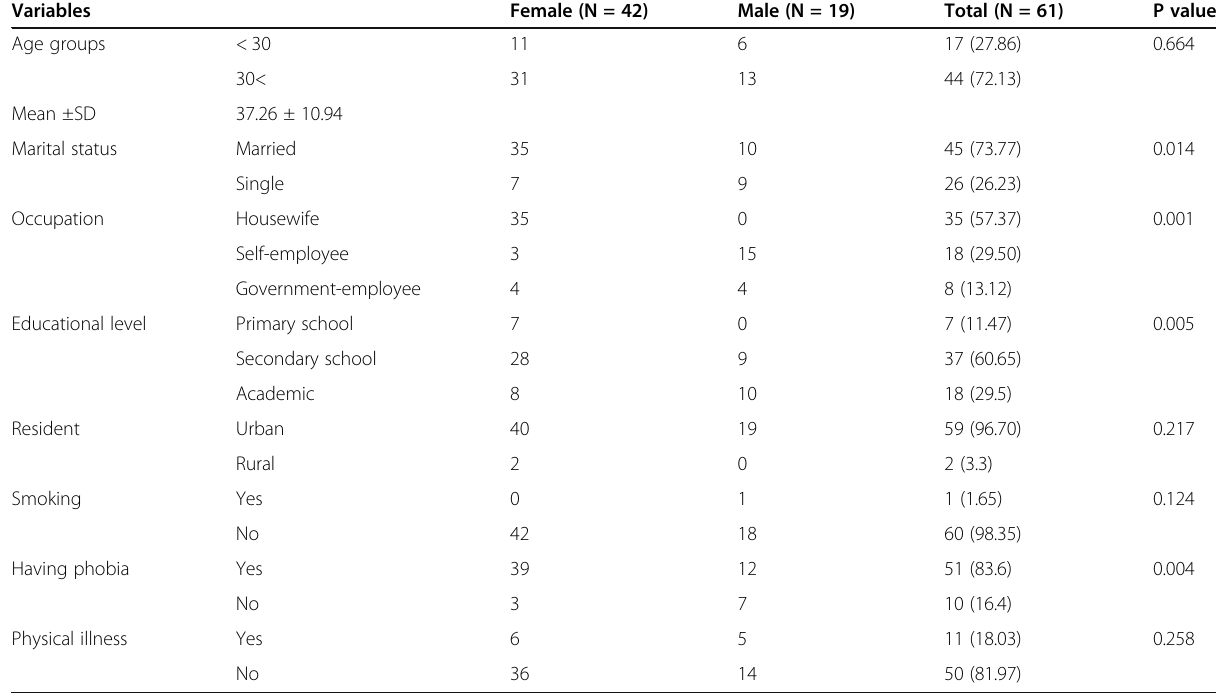
Table 1 Selected socio-demographic characteristics of participants with agoraphobia Variables Female (N =